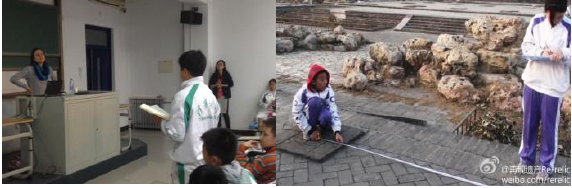
Figure 1. Students having class with Dr. Harrer and surveying